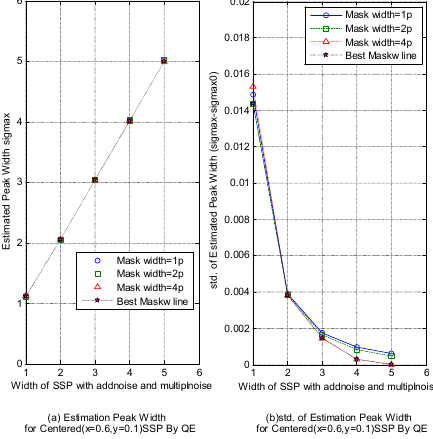
Figure 6 QE estimation of width when Sinc peak is at x =0.6, y =0.1 with 10dB